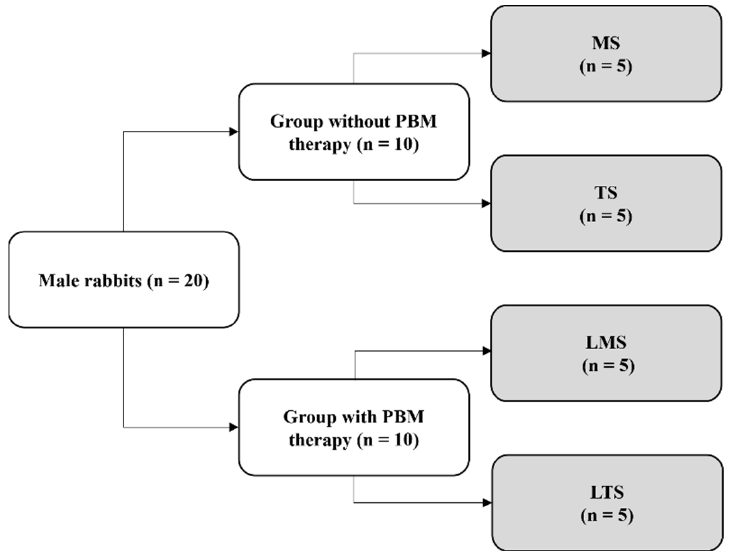
Figure 1. Division of animals into four groups according to the surface of the implant received and the application of PBM therapy.